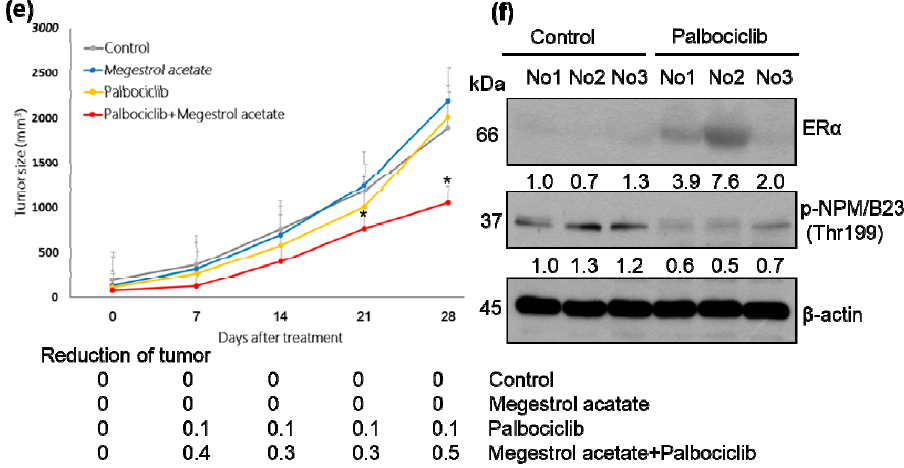
Figure 2. Palbociclib renders endometrial cancer cells susceptible to megestrol acetate by inducing ER α expression. ( a , b ) ARK2 cells were treated with vehicle (-) or different doses of palbociclib alone (0, 2.5, 5, 10, and 20 µM), megestrol acetate alone (0, 2.5, 5, 10, and 20 µM), or their combination for 72 h. Cell survival was assessed using the MTT assay. Data are expressed as fold change ± SD relative to vehicle-treated cells. All experiments were performed in triplicate (left panel). The synergistic effect of palbociclib and megestrol acetate was analyzed with the CompuSyn software (right panel). ( c ) ARK2 cells were treated with vehicle (-), different doses of palbociclib alone (0, 1.25, 2.5, 5, 10, and 20 µM), megestrol acetate alone (0, 1.25, 2.5, 5, 10, and 20 µM), or a combination (palbociclib plus megestrol acetate) for 5 days. Colony formation was analyzed with the clonogenic assay. ( d ) ARK2 cells were treated with vehicle (-), palbociclib (0, 5, and 10 µM), megestrol acetate (0, 5, and 10 µM), or a combination (palbociclib plus megestrol acetate) for 24 h. Cleaved PARP protein levels (as an index of apoptosis) were analyzed by western blotting. Values measured on densitometry (shown at the bottom) were normalized with that observed in vehicle-treated cells (set at 1). All experiments were performed in triplicate, and β -actin served as the loading control for normalization. ( e ) ARK2 were inoculated into nude mice, inhibitory effect of palbociclib plus megestrol acetate on cancer growth in a xenograft tumor model. ( f ) Extracts from tumors exposed to palbociclib, megestrol acetate, or a combination were immunoblotted with antibodies raised against ER α , phospho-NPM/B23 (Thr199), and β -actin. Densitometry-derived values (bottom) are normalized with the control that was set as 1. Data shown are derived from three independent experiments. β -actin serves as the loading control for normalization.